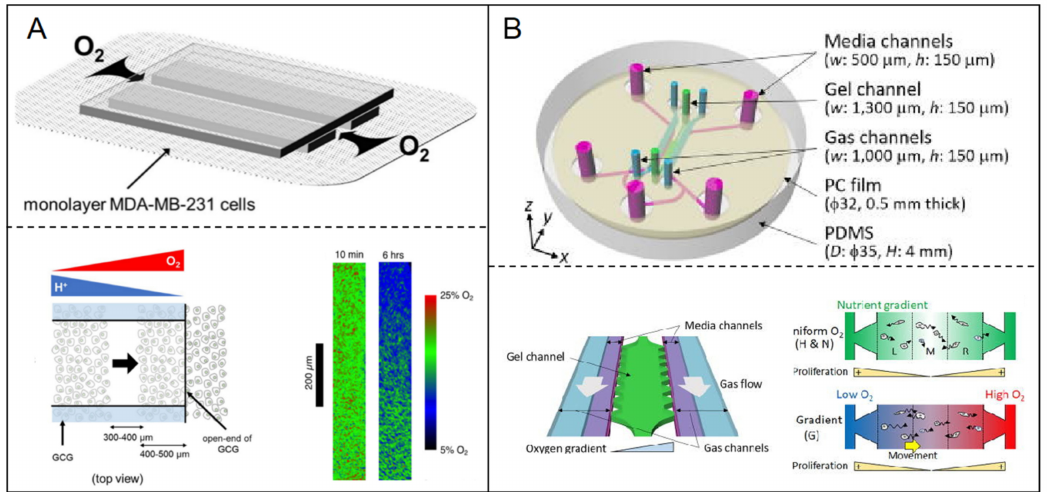
Figure 5. Hypoxia model in breast tumor-on-a-chip. ( A ) The gradient of oxygen concentration was established in microflu- idic chip by cellular oxygen consumption in the relatively closed spaces [71]. Open access; ( B ) A linear oxygen gradient from 3% to 17% was generated through the oxygen permeability of ECM. The response of breast cancer cells to different oxygen tension was investigated using the hypoxia microfluidic system [72]. Open